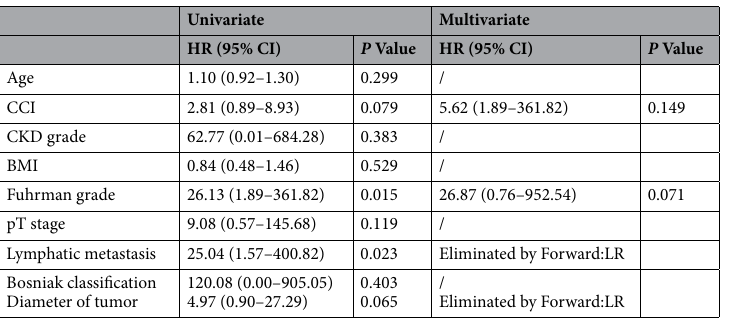
Table 4. Cox regression analysis of overall survival for 74